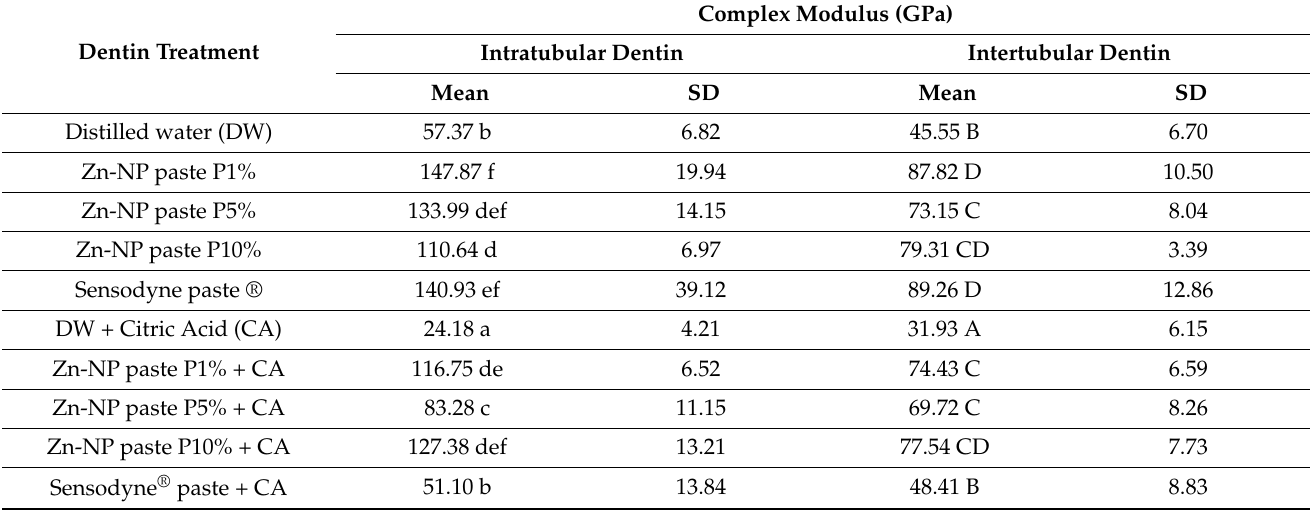
Figure 2. Nano-DMA mapping of the EDTA-treated dentin surfaces, after the following the treat- ments: ( a ) brushed with distilled water and ( b ) after-treated with citric acid; ( c ) brushed with toothpaste containing 1% of Zn-NPs and ( d ) after-treated with citric acid; ( e ) brushed with toothpaste containing 5% of Zn-NPs and ( f ) after-treated with citric acid; ( g ) brushed with toothpaste containing 10% of Zn-NPs and ( h ) after treated with citric acid; and ( i ) brushed with Sensodyne ® toothpaste and ( j ) after treated with citric acid. The pixel data array for the mapping is organized according to the complex modulus distribution that concurs with a clear delimitation between intertubular and peritubular dentin. For the color scheme shown, the red color corresponds to the highest value of the locally measured complex modulus (E*), likely corresponding to the highest resistance to defor- mation and potentially associated with mineral precipitation. In most of the cases, it corresponds to intratubular locations (asterisks). Scale bars are in GPa. Scan size is 15 µ m × 15 µ m. Table 1. Means and standard deviations (SD) of the complex modulus (GPa) of dentin at intertubular and intratubular spaces, after the different